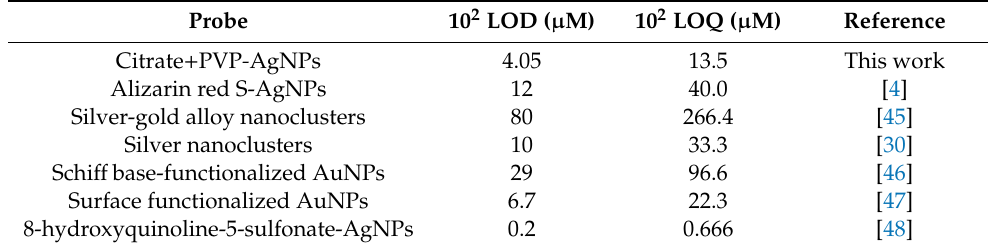
Table 3. Comparison of the sensitivity data using different AgNPs/AuNPs-based sensors.